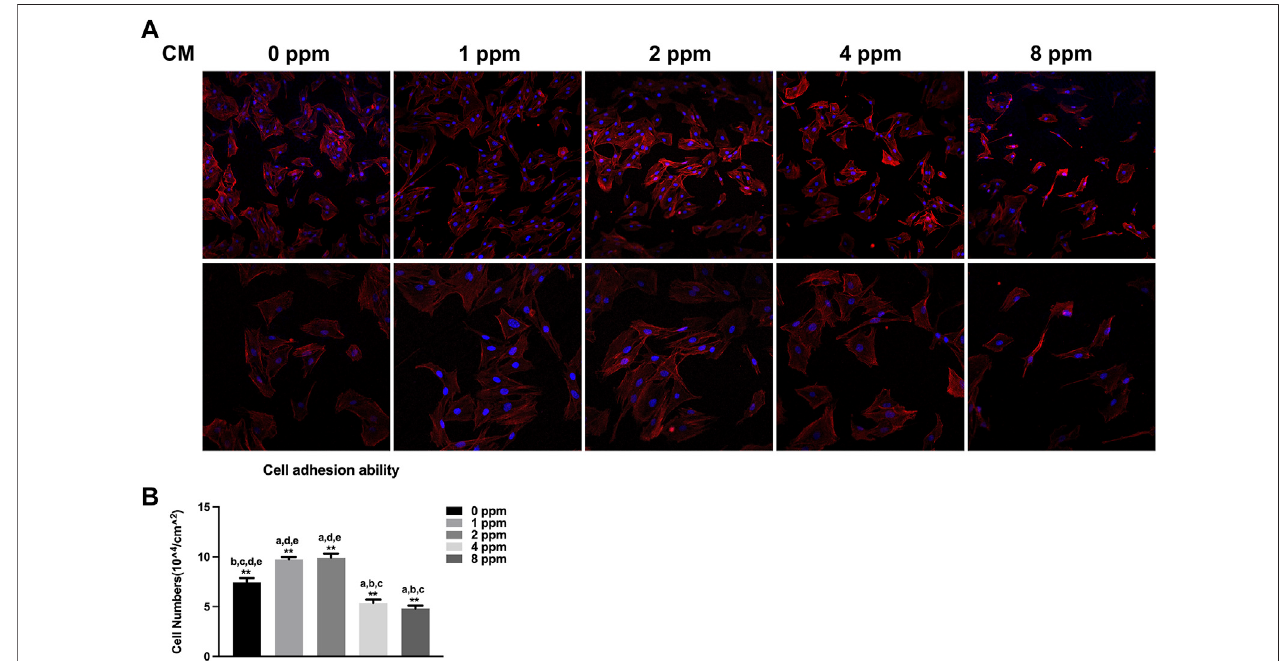
FIGURE 7 | Cell adhesion ability assay. The adhesion ability of MC3T3-E1 cells was analyzed by counting the stained nuclei with DAPI using a confocal laser scanningmicroscope(CLSM) afterincubation. (A) CLSMimages ofthecellsunder differentconcentrationsofCM at×100and ×200magni fi cation. (B) Statistical results for adhesive cell numbers (* p < 0.05,** p < 0.01; N = 3).